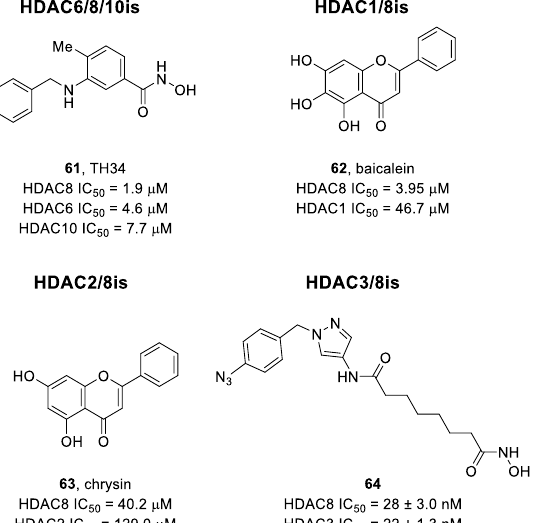
Figure 11. Representation of reported multi-target HDAC6/8/10is and dual HDAC1-3/8is [170,175,176,178].